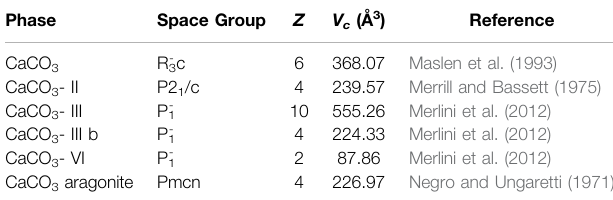
TABLE1| CrystallographicdataforcalciteI-VIandaragonite. V c isthevalueofthe cell, and Z is the number of formula units in the unit cell.